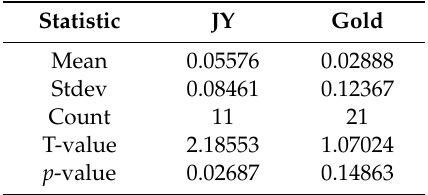
Table A4. h c − h T (HRs based on Indian Rps).